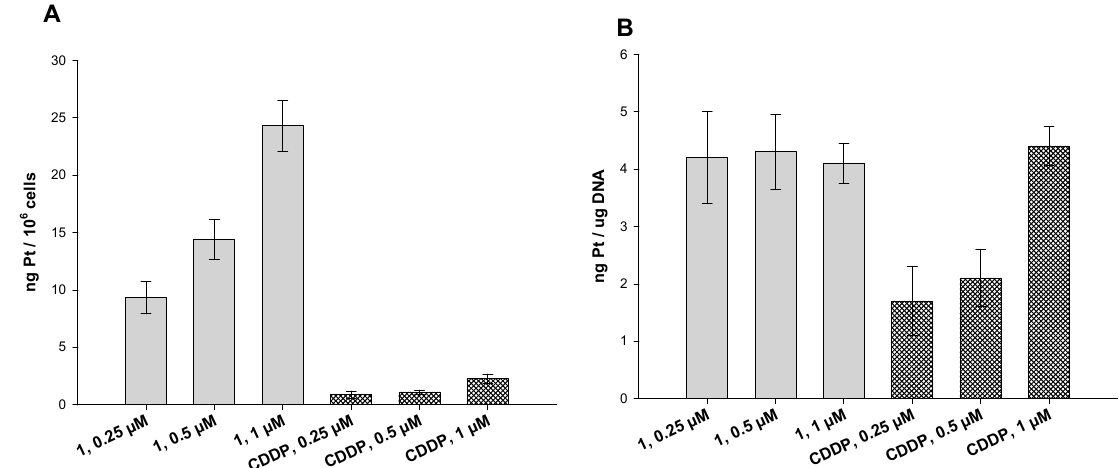
Figure 3. Cellular uptake ( A ) and DNA platination ( B ). ( A ) HCT-15 cells were incubated for 24 h with increasing concentrations of 1 or CDDP. The error bars indicate SD. ( B ) Platination levels of nuclear DNA extracts. HCT-15 cells were treated for 24 h with increasing concentrations of 1 or CDDP. DNA was extracted, quantified, and the amount of Pt bound to DNA was estimated using GF–AAS. Error bars indicate SD.